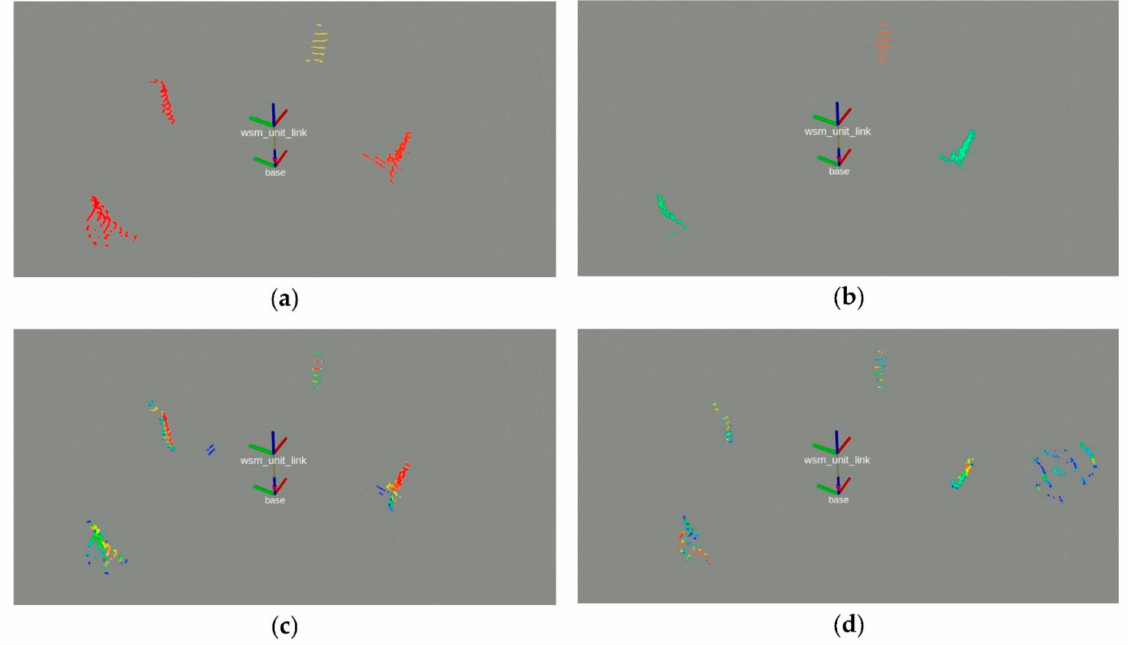
Figure 9. Point clouds representing the presence of a human co-worker. ( a ) E Y − RGB ; ( b ) E Y − Thermal ; ( c ) E B − RGB ; ( d ) E B − Thermal